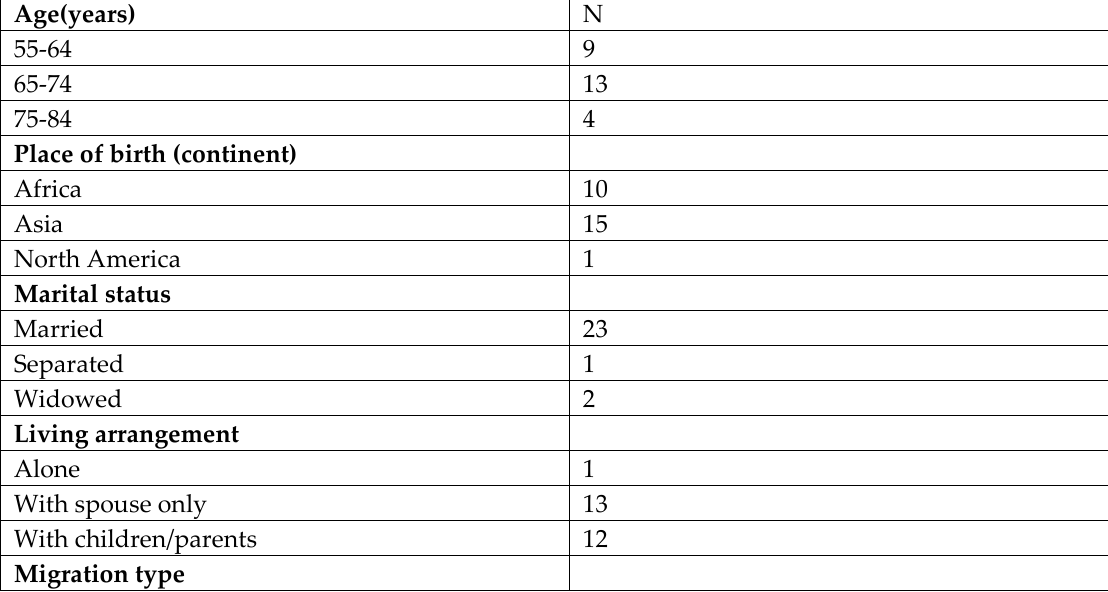
Table 1: Descriptive characteristics of South Asian Indian participants